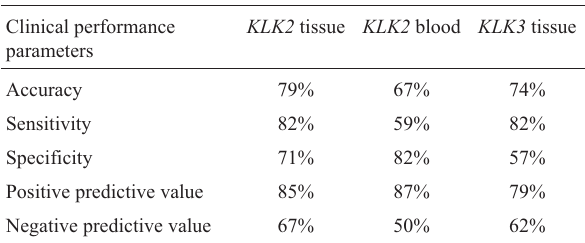
Table 2 - Calculation of clinical performance parameters of total serum prostate-specific antigen (tPSA) and the molecular markers KLK2 and KLK3 in peripheral blood and prostate tissues for prostate cancer diagnostics.